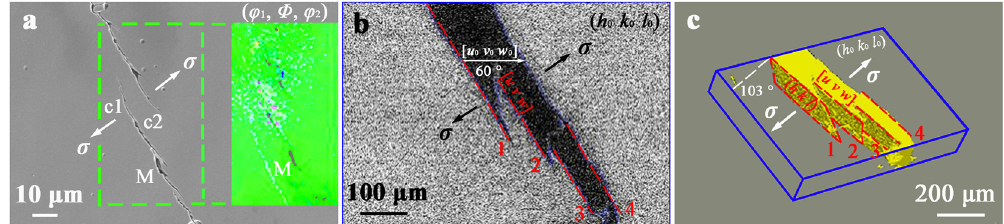
Fig. 1 Non-slipping SCC on cleavage planes (1 0 0). a The SEM morphologies of the surface cracks ‘ c1 ’ and ‘ c2 ’ , along with the dotted-green- rectangle and ‘ M ’ -marked surface crystallography corresponding to the Euler angle ( φ 1 , Φ , φ 2 ) = (317.8°, 10.3°, 18.9°) characterized by the EBSD. b The XCT morphologies of a surface-parallel crossing section with the Euler angle ( φ 1 , Φ , φ 2 ) = (317.8°, 10.3°, 18.9°), the original crystal plane ( h 0 k 0 l 0 ), the original crystal direction [ u 0 v 0 w 0 ], and the SCC propagation direction [ u v w ], in which the angle of [ u 0 v 0 w 0 ] and [ u v w ] is 60°, and the crack edges and the cleavage plane edges are indicated by the dotted red lines ‘ 1 ’ , ‘ 2 ’ , ‘ 3 ’ and ‘ 4 ’ . c The partial through-thickness XCT morphologies of the SCC cracks with the cleavage planes ( h k l ), in which the angle of ( h 0 k 0 l 0 ) and ( h k l ) is 103°, and the crack edges are also indicated by the dotted red lines ‘ 1 ’ to ‘ 4 ’ , and the SCC cracks are marked by yellow. The calculations show that ( h k l ) was (1 0 0), and the SCC advanced along the cleavage planes (1 0